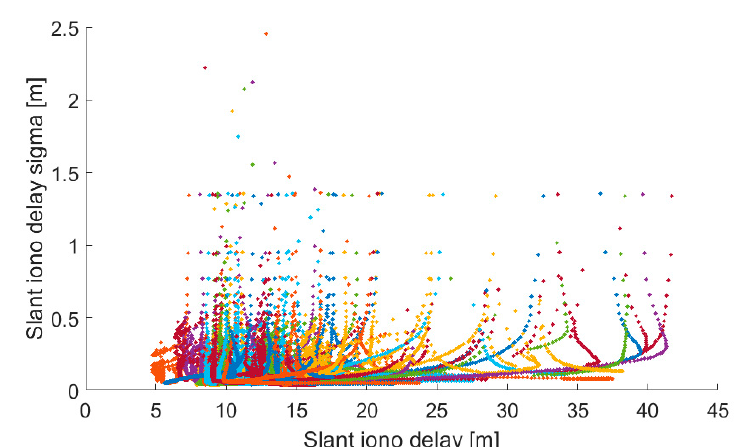
Figure 5. Correlation between estimated slant delays and their sigmas. Correlation coefficient equals 0.19. Each colour marker point represents a particular satellite. Delays are shown for DOY 253, 2018 for GMSD station, located in Japan.